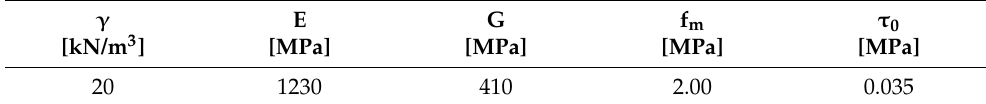
Figure 2. ( a ) Detail of the masonry walls of the building; ( b ) Masonry texture (inspection window dimension 40 × 40 cm). Table 1. Mechanical properties of the masonry.